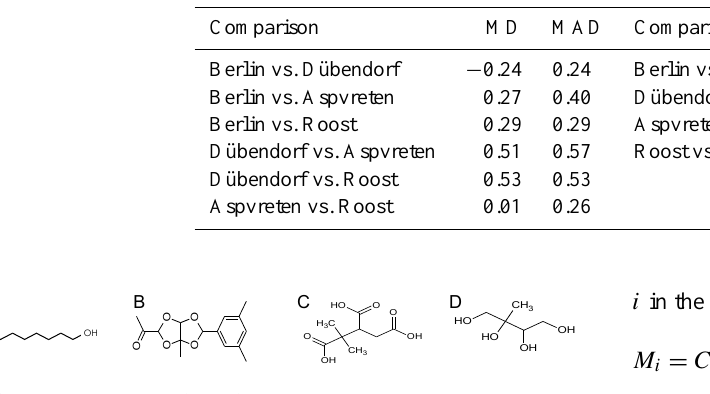
Figure 4. Structure of the four molecules considered as possible surrogates for secondary organic aerosol: octan-1-ol (Finizio et al., 1997) ( a ), water insoluble organic matter B (Kalberer et al., 2004) ( b ), 3-methylbutane-1,2,3-tricarboxylic acid (MBTCA) (Szmigiel- ski et al., 2007) ( c ) and 2-methylbutane-1,2,3,4-tetrol (MT) (Claeys et al., 2004) ( d